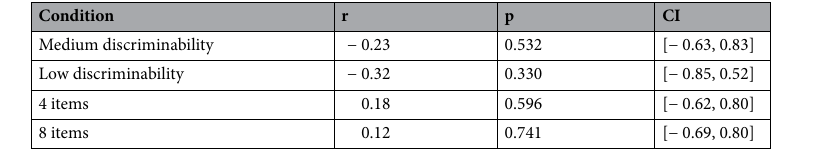
Table 4. Correlation between individual PLD peak latency and average stimuli duration in each experimental condition. CI: 95% confidence interval.